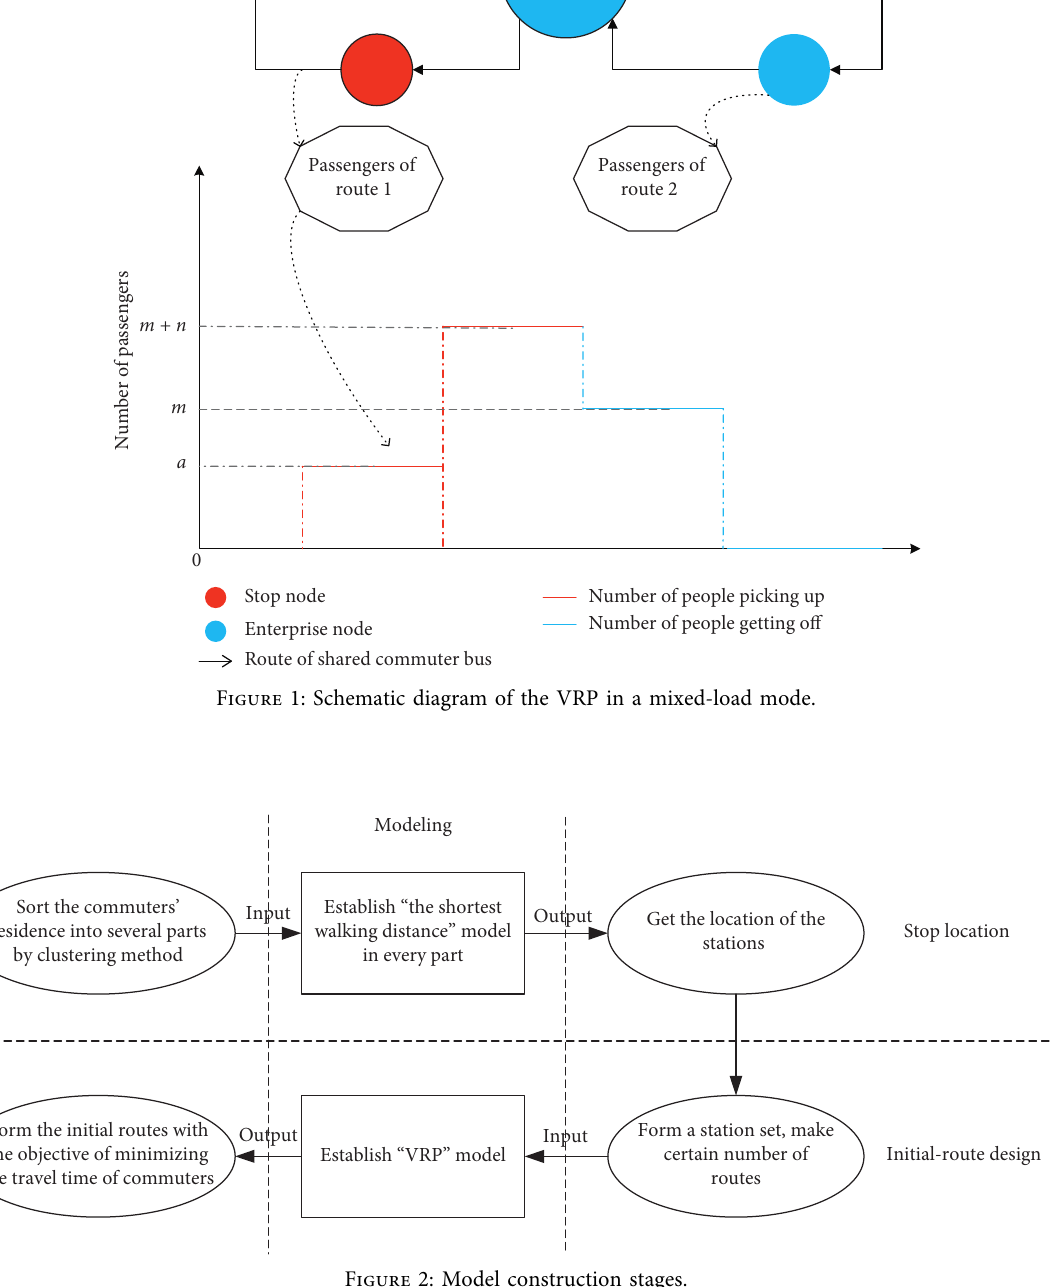
Figure 2: Model construction